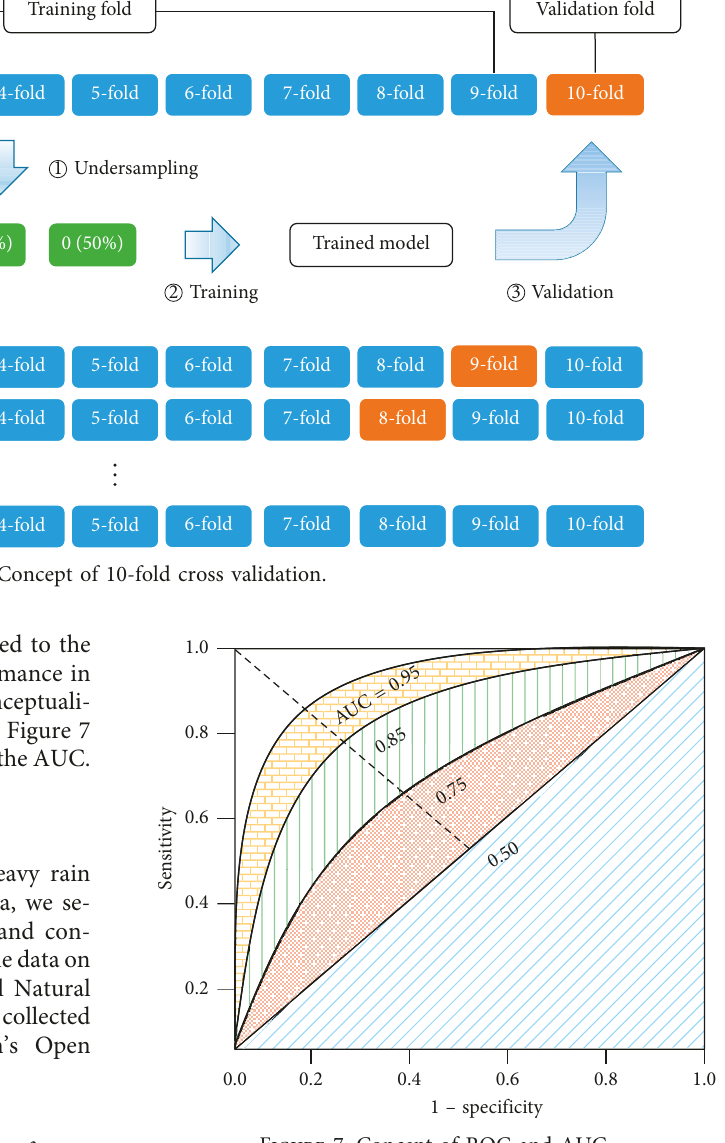
Figure 7: Concept of ROC and